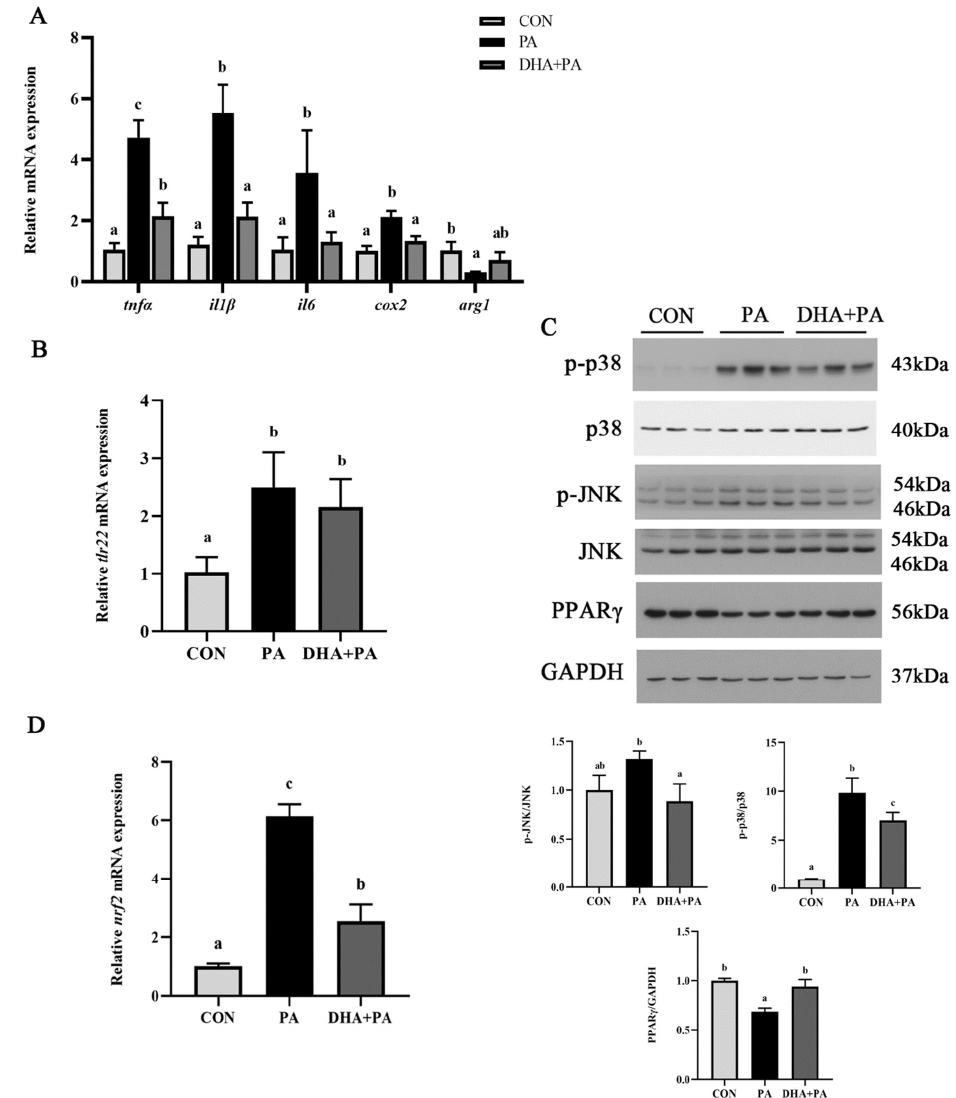
Figure 8. The protective effect of DHA against PA-induced inflammation. ( A ) mRNA expression levels of inflammatory genes after DHA treatment ( n = 4). ( B ) The mRNA expression level of tlr22 after DHA treatment ( n = 4). ( C ) Western blot analysis of MAPK signaling activation and the PPAR γ protein level after DHA treatment ( n = 3). The ratios of p-p38 to p38, p-JNK to JNK and PPAR γ to GAPDH were determined. ( D ) The mRNA expression level of nrf2 after DHA treatment ( n = 4). Data are presented as the means ± SEM and analyzed using one-way ANOVA, followed by Tukey’s test. Bars labeled with the same letters are not significantly different ( p > 0.05).